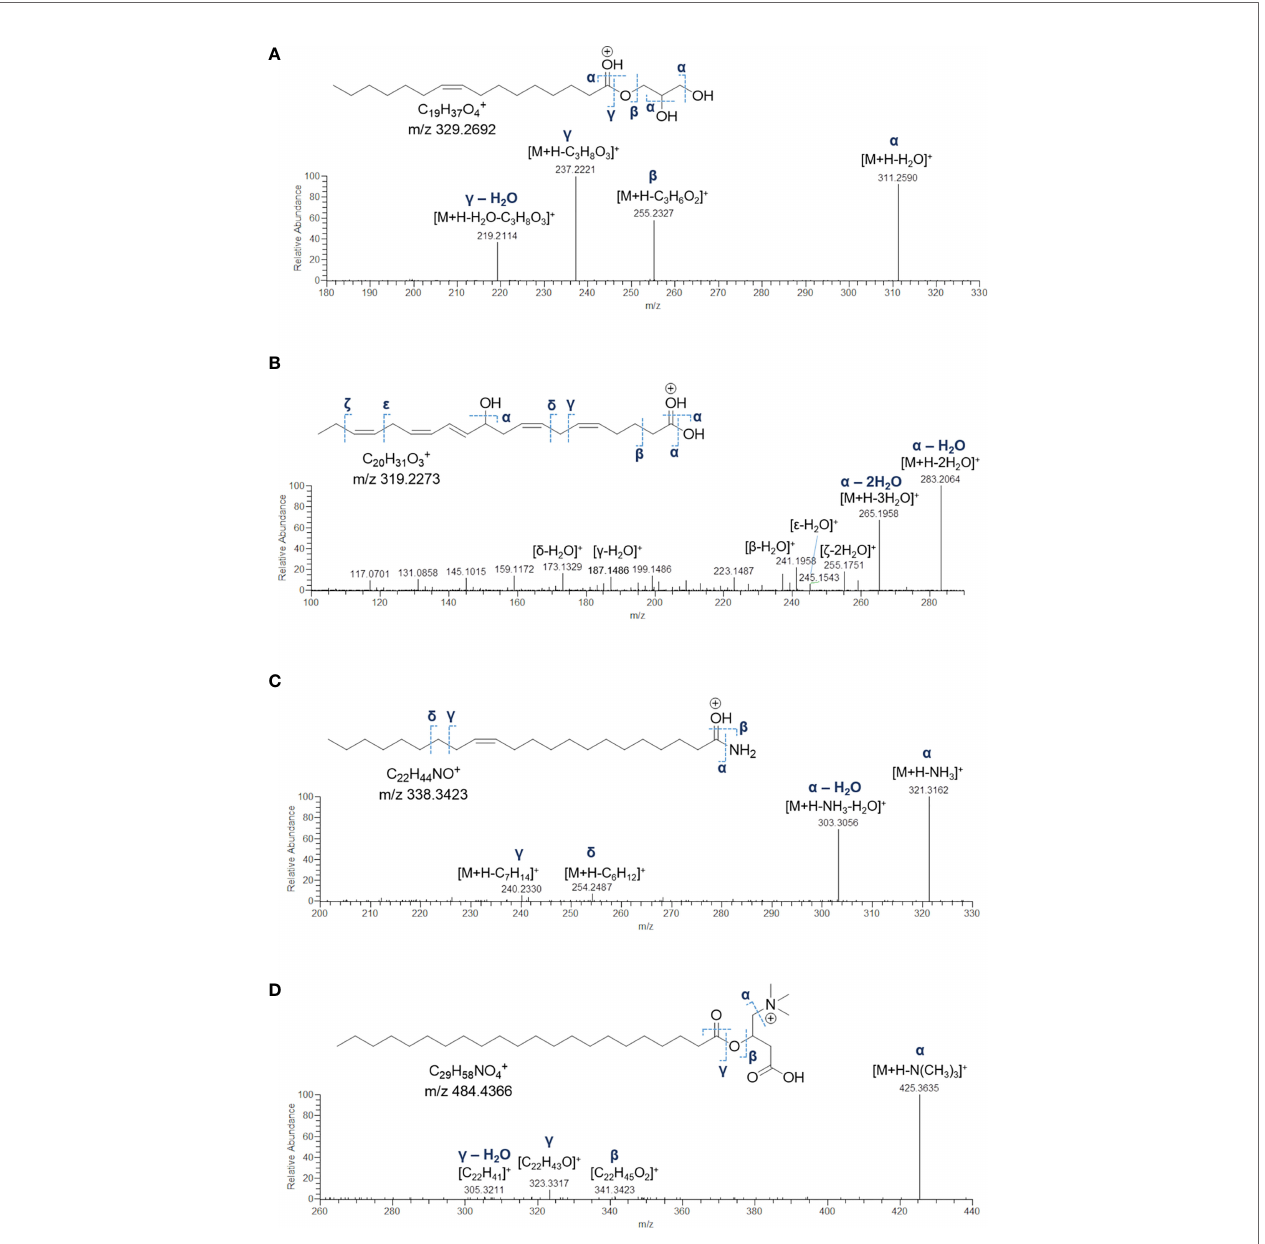
FIGURE 8 | Fragmentation patterns and HR ESI-MS 2 spectrum of the [M+H] + ion of 1-(9 Z -octadecenoyl)- sn -glycerol (MG 16:1) (A) , the [M+H-H 2 O] + ion of 11-hydroxy- 5 Z ,8 Z ,12 E ,14 Z ,17 Z -eicosapentaenoic acid (FA 20:5;O) (B) , the [M+H] + ion of 13 Z -docosenamide (AM 22:1) (C) , and the [M+H] + ion of the docosanoylcarnitine (CAR 22:0) (D)